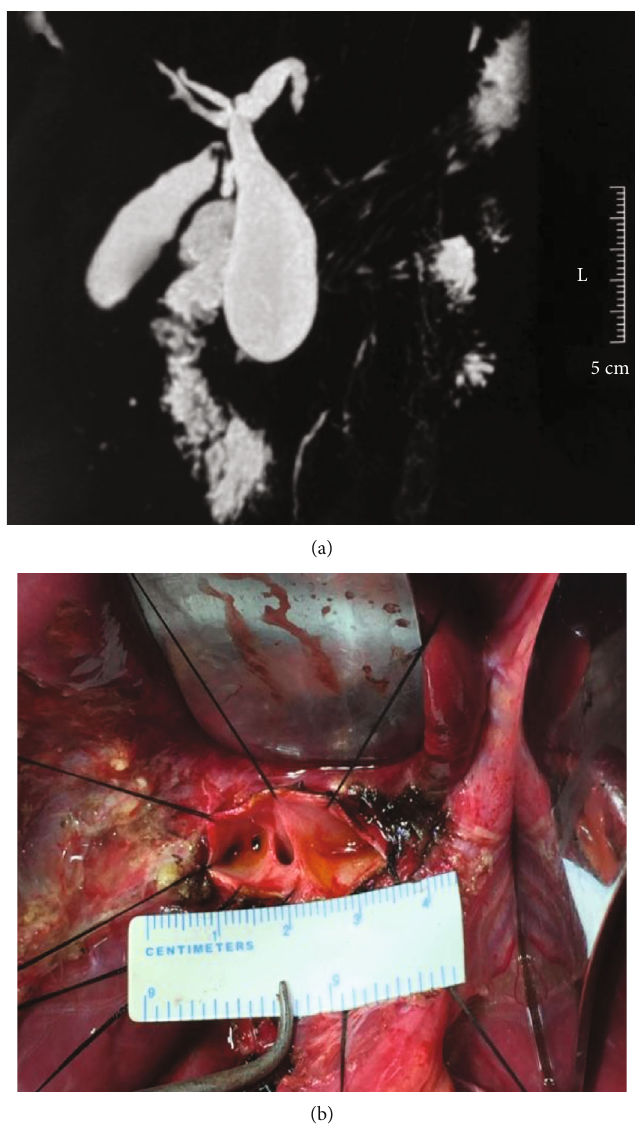
Figure 2: (a) Ultrasonographic image of type Ia CDBD. (b) Completed appearance of a hilar ductoplasty in type Ia